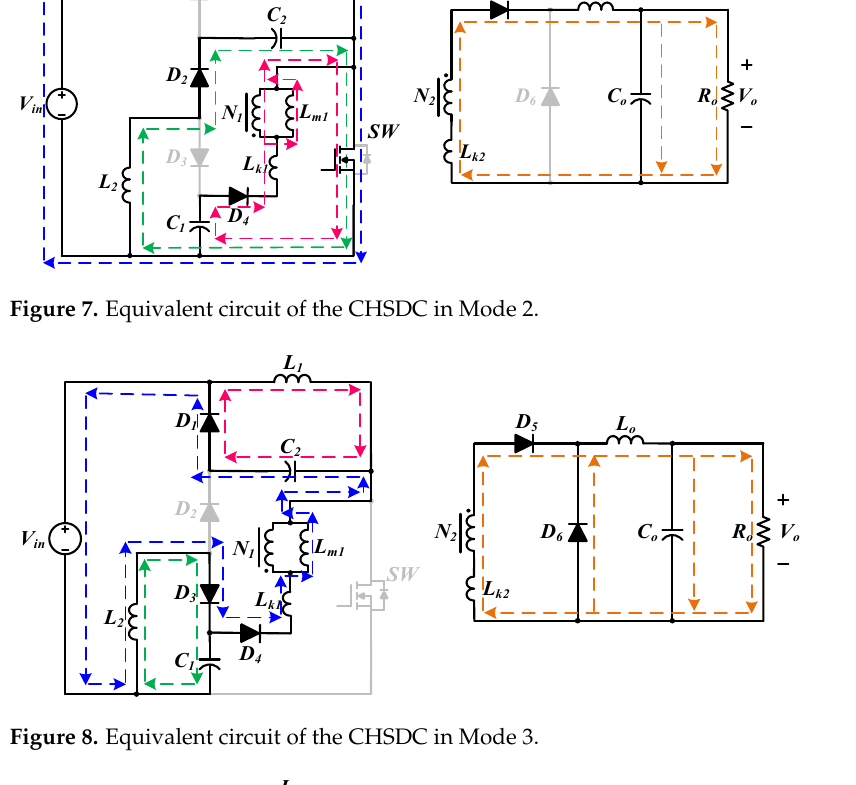
Figure 9. Equivalent circuit of the CHSDC in Mode 4.